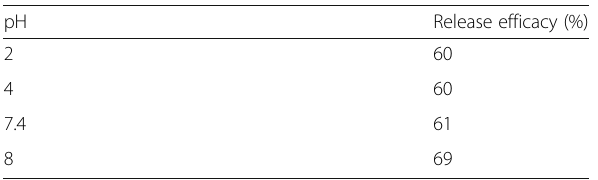
Table 2 Release efficiency of PNIPAM derivatives at various pH